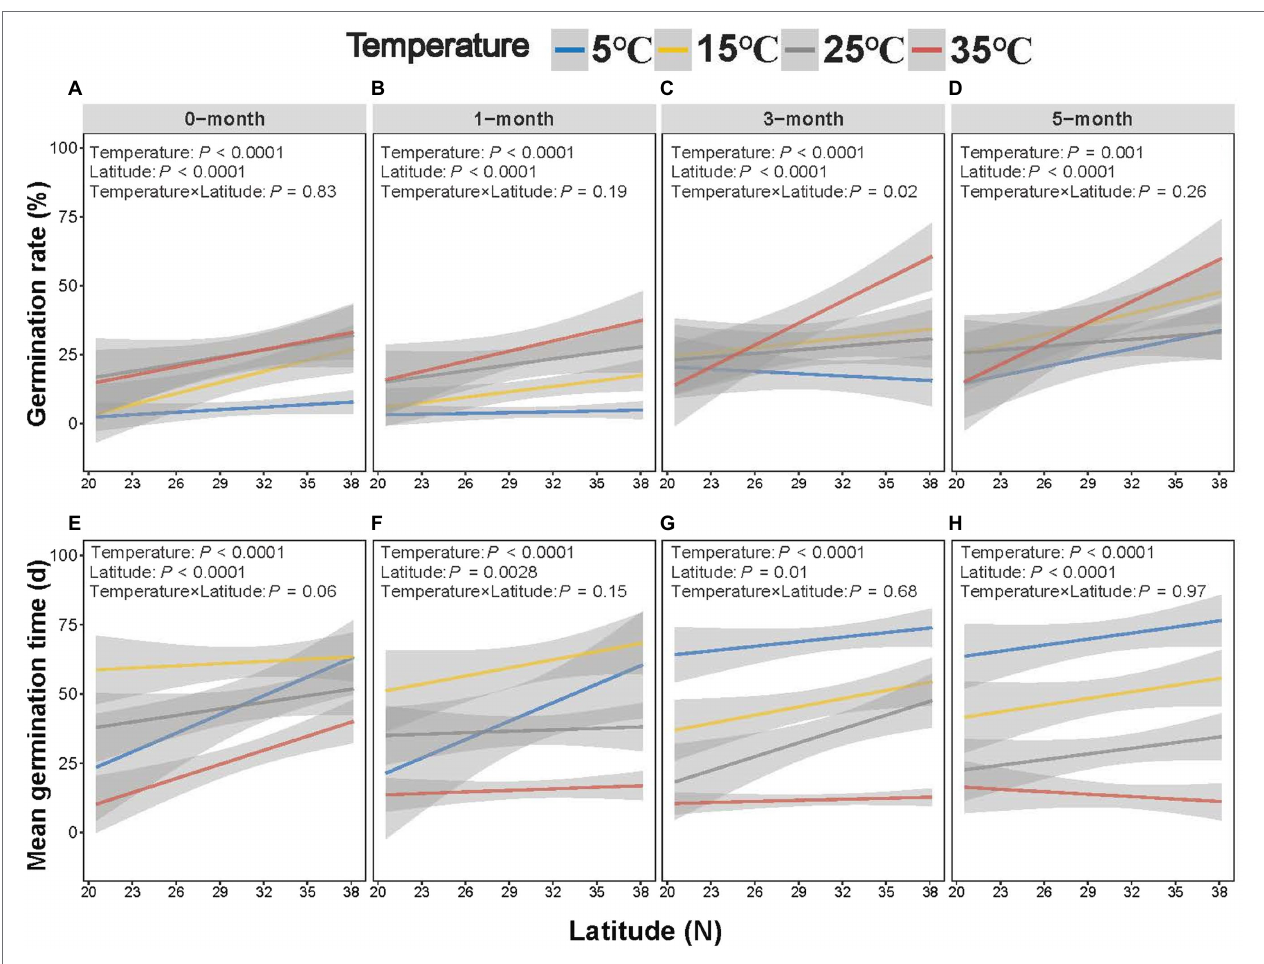
FIGURE 4 | Effect of temperature/stratification treatments on the germination rate (A–D) and mean germination time (E–H) of Spartina alterniflora seeds from different latitudinal provenances (shaded area indicates 95% CI).